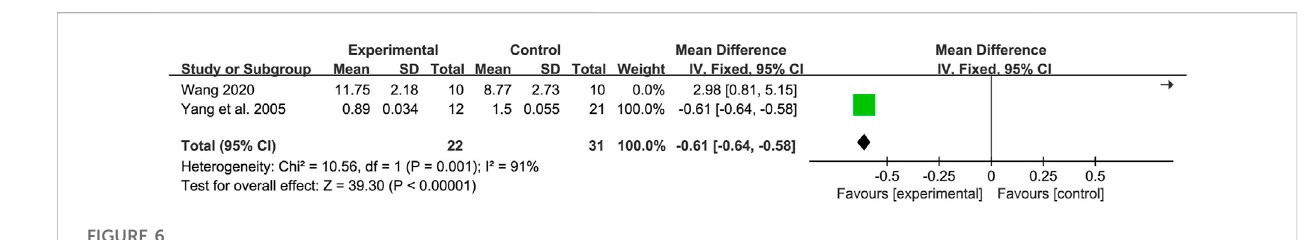
FIGURE 6 Forest map of thymus index.